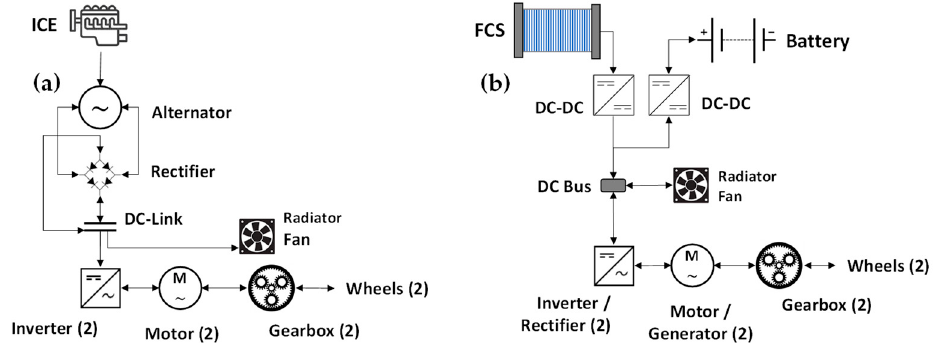
Figure 1. Powertrain configurations: ( a ) diesel genset; ( b ) hybrid fuel cell. The reference diesel truck has an electric drivetrain with dual motors and gearboxes. The fuel cell powertrain retains the same electric drivetrain but has DC–DC converters for matching the voltages of the battery, FC stack, and traction motors.